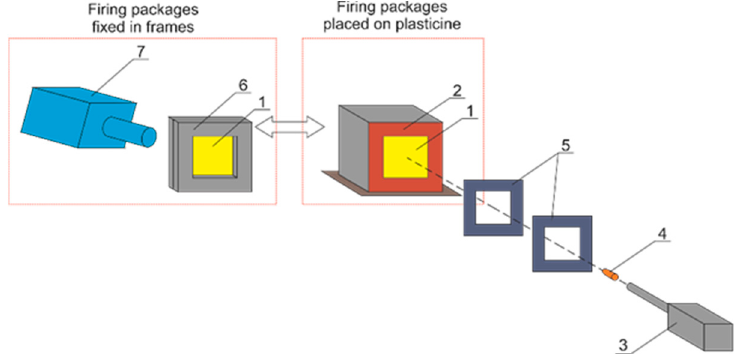
Figure 3. Diagram of the ballistic test stand (1—ballistic package; 2—mold with ballistic plasticine; 3—ballistic cannon; 4—bullet trajectory; 5—set of gates for measuring the velocity of the bullet; 6—steel clamping frames; 7—camera for quick registration) .